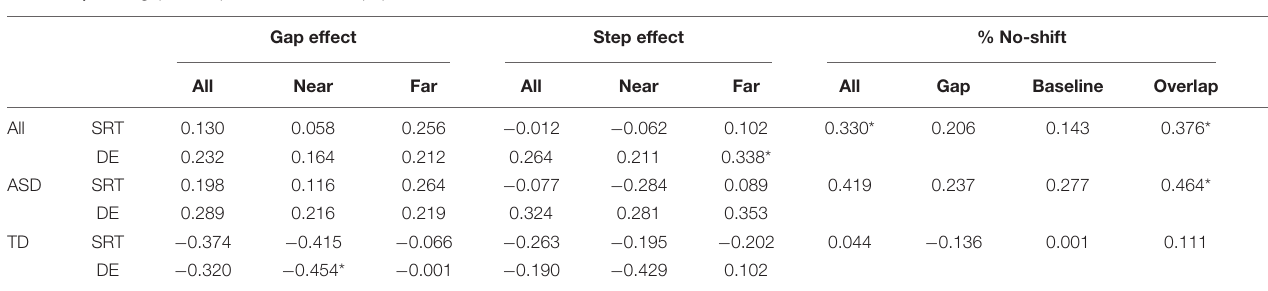
FIGURE 3 | Saccadic reaction time gap (overlap-gap; top row) and step (overlap-baseline; bottom row) effects for visual (left column) and auditory (right column) for ASD (gray) and TD (white) groups. Error bars represent ± 1 SEM. ** p < 0.05, * p < 0.1. TABLE 2 | Visual gap-overlap correlations with pupil